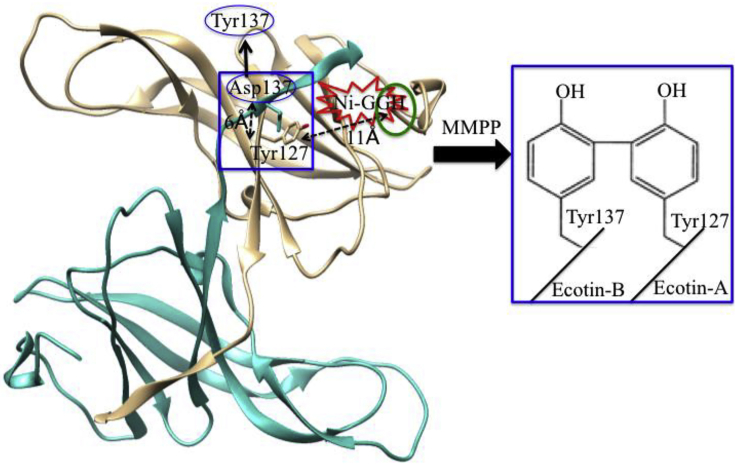
The Formation of Tyrosine Cross-Linking Product by Ni-ATCUN in GGH-Ecotin (D137Y)The ecotin structure is derived from the PBD: 1ECZ (Shin et al., 1996). The Ni-ATCUN (red star) is assumed to bind N-terminus (green circle) of ecotin-A (gray) and distance from Tyr127 is ~11 Å. The distance between mutant Asp137→Tyr137 in ecotin-B (cyano) and wild Tyr127 in ecotin-A (gray) is 6 Å (highlighted blue box). MMPP = monoperoxyphthalate.